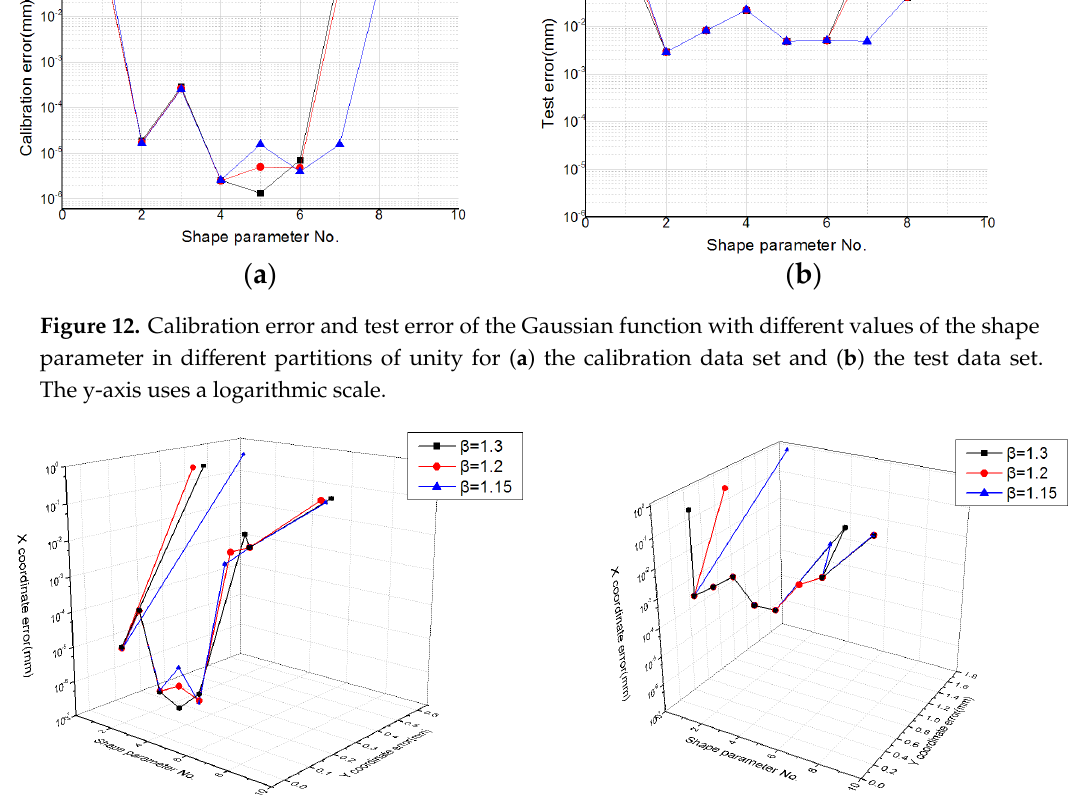
Figure 12. Calibration error and test error of the Gaussian function with different values of the